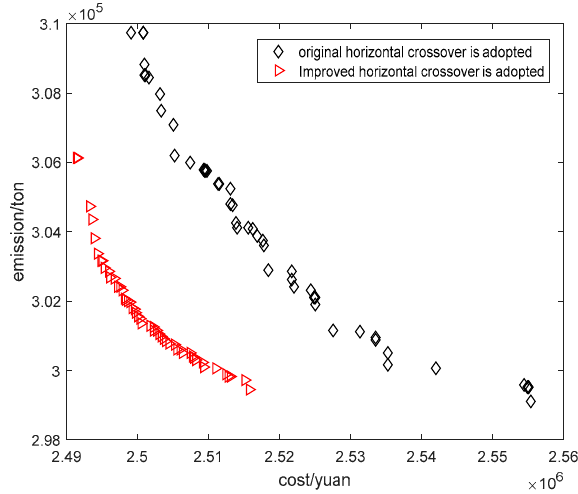
Figure 5. Comparison of results of improved horizontal crossover.